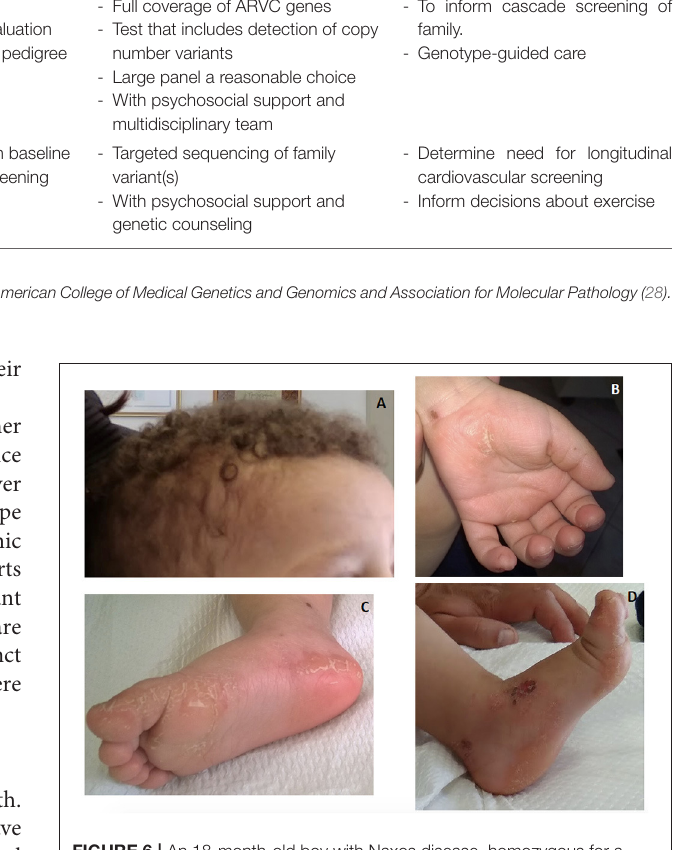
FIGURE 6 | An 18-month-old boy with Naxos disease, homozygous for a pathogenic JUP variant. Wooly hair apparent from birth (A) and mild hyperkeratosis on palmar and more prominent on plantar areas (B) and (C). Eczematous lesions and fragile skin with erosion on the dorsal foot area (D)